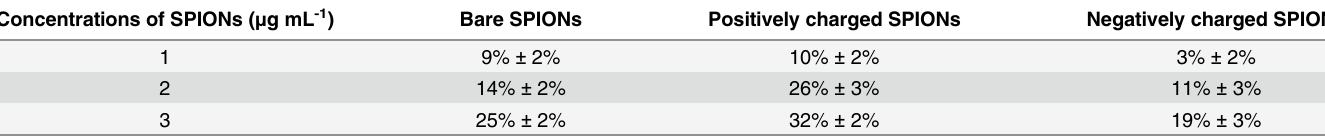
Table 2. The proportion of dead cells to total cells in the S . mutans biofilms following 3h of incubation with the bare, positively charged and nega- tively charged SPIONs. Data were obtained after correction for the number of dead cells in the control images (stained bacteria without SPIONs), which was 10% ± 5%. N =